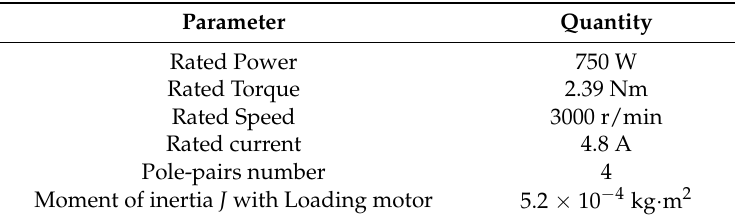
Table 3. PMSM Specifications.